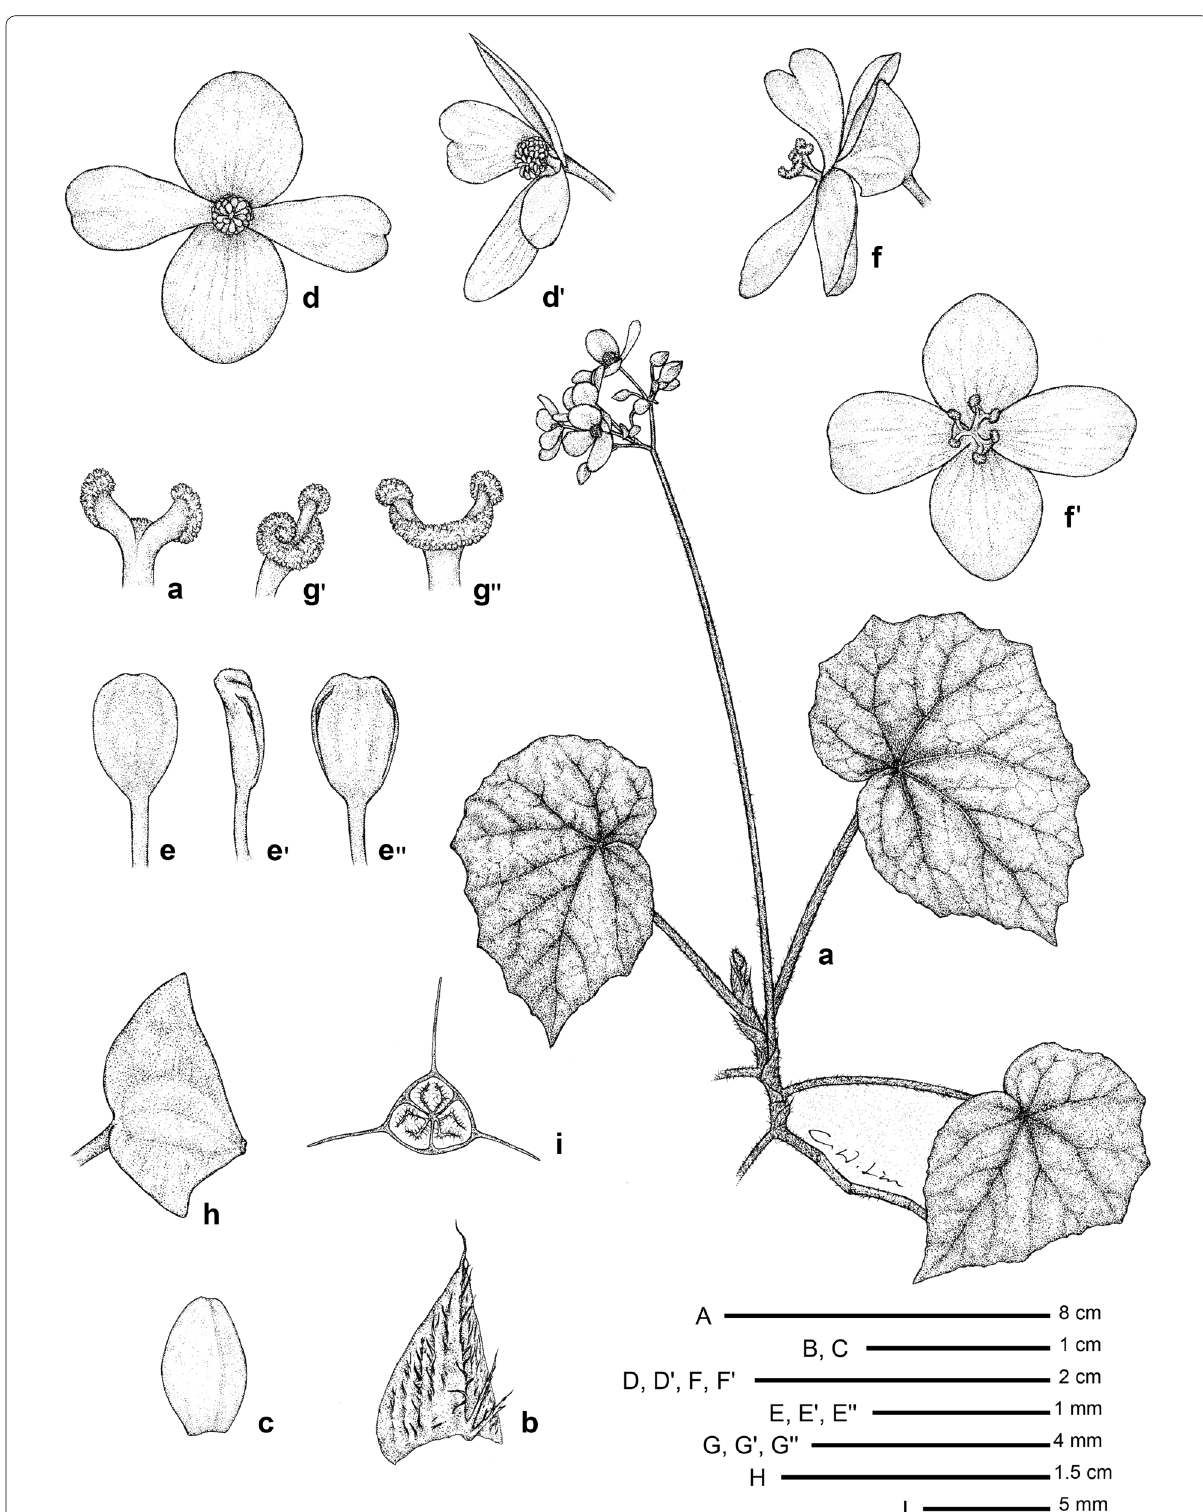
Fig. 3 Begonia merrilliana C.‑I Peng, R. Rubite, C.W. Lin & K.F. Chung . A Habit; B stipule; C bract; D , D ′ staminate flower, face and back views; E , E ′ , E ′′ stamen, dorsal, side and ventral views; F , F ′ pistillate flower, side and face views; G , G ′ , G ′′ style and stigmatic band, ventral, side and dorsal views; H Capsule; I Cross section of an immature